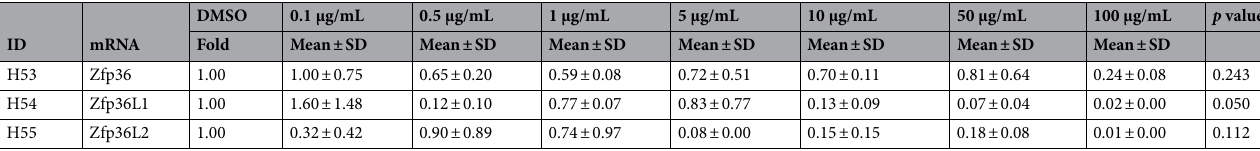
Table 3. Gossypol Dosages on Colon Cancer Cell Gene Expression. The data represent the mean and standard deviation of three independent samples. Data with different lowcase letters represent significance between the treatments p < 0.05. ud: undetected. Bold italics: mRNA levels were statistically decreased by gossypol among the treatments with various concentrations. Italics: mRNA levels were statistically increased by gossypol among the treatments with various concentrations. "*" under P value column represents mRNA levels significantly affected by gossypol. Statistical analyses were conducted with Student–Newman–Keuls method for all pairwise multiple comparison. All pairwise multiple comparison was also performed with Tukey test yielding similar results (data not